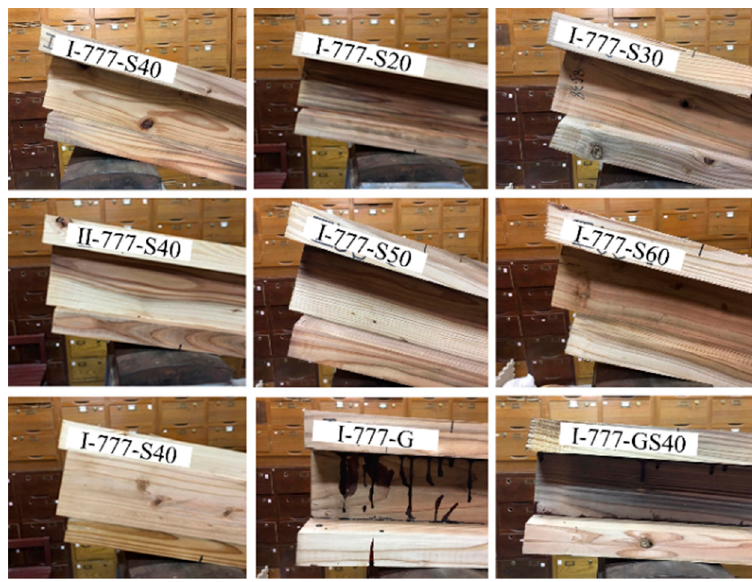
Figure 9. End slip of the built-up beams.